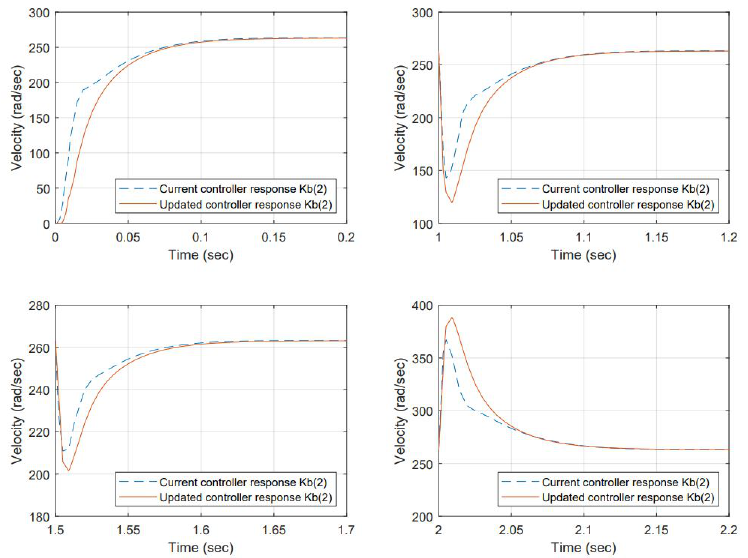
Figure 15. System response to a Back EMF change ( K b = 0.0342)—sample 2. The dynamic response at initial conditions and load accepts and load rejects reaches 63% of the reference approximately at 0.025 s, the steady-state error is 0% at the stable point after 0.15 s. In terms of performance, the proposed gains have room for improvement to reduce overshoot and increase speed response.